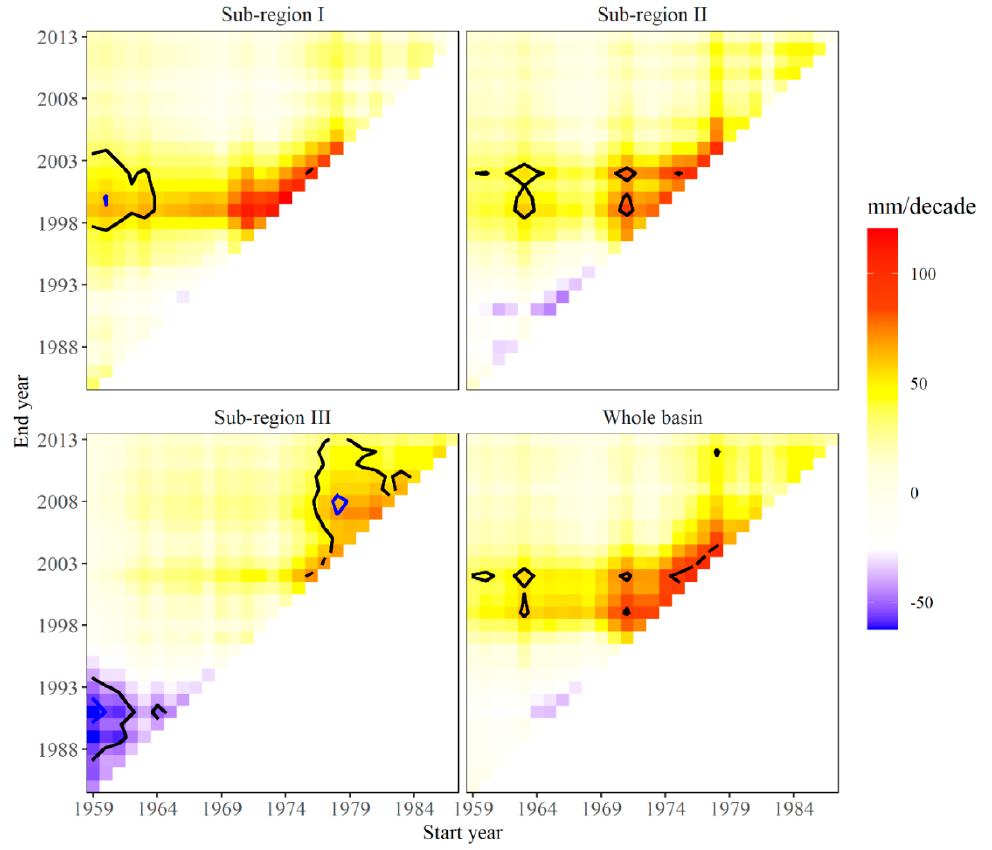
Figure 6. Multiple trend analyses for mean summer precipitation of sub-regions and the whole basin. The colour scale indicates the change in mean summer rainfall in mm per decade. The thick blue and black contours delineate areas of significant trends at 1 and 5% significance level, respectively.